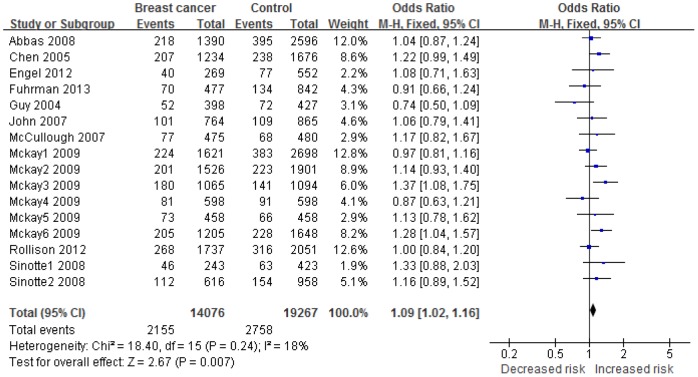
Forest plots of association of Fok1 polymorphism with breast cancer.Significant association was detected between the genotype ff and breast cancer in recessive model (ff vs. Ff+FF). The squares and horizontal lines correspond to OR and 95% CI of specific study, and the area of squares reflects study weight. The diamond represents the pooled OR and 95% CI. Heterogeneity was checked by the chi square based Q test.